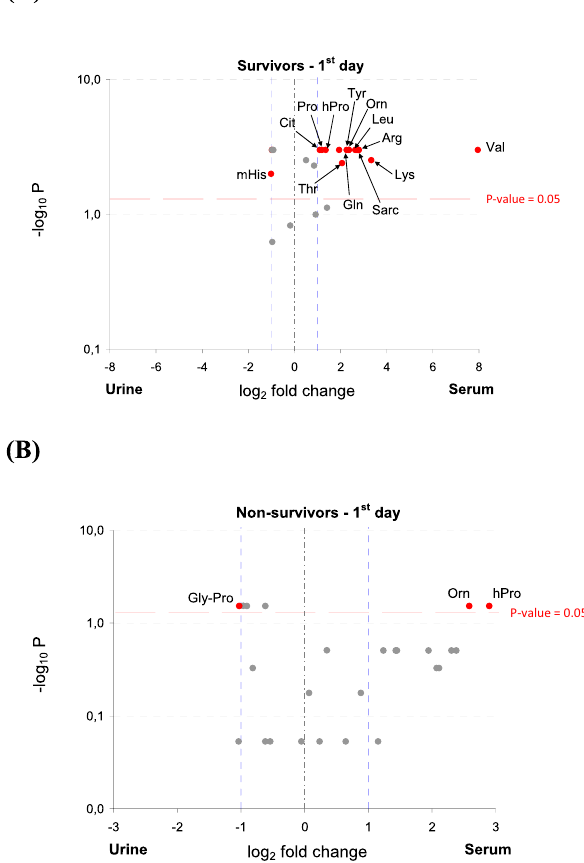
Figure 4. Volcano plot indicating the amino acids with the most meaningful changes analyzed in the urine and serum of survivors ( A ) and non-survivors ( B ) on admission based on univariate analysis—y-axis: Mann–Whitney p value, x-axis: fold change (FC). Each dot represents one amino acid. The amino acids with significance p < 0.05 are located above the red horizontal line. The amino acids with more than a twofold change of a concentration are located on right and left from the respective blue right and left vertical lines. Only red dots indicate amino acids with the clinical and statistical differences. Arg, arginine; Cit, citrulline; Gln, glutamine; Gly-Pro, glycine-proline; hPro, 4-hydroxyproline; Leu, leucine; Lys, lysine; mHis, 3-methyl-histidine; Orn, ornithine; Pro, proline; Sarc, sarcosine; Thr, threonine; Tyr, tyrosine; p , significant